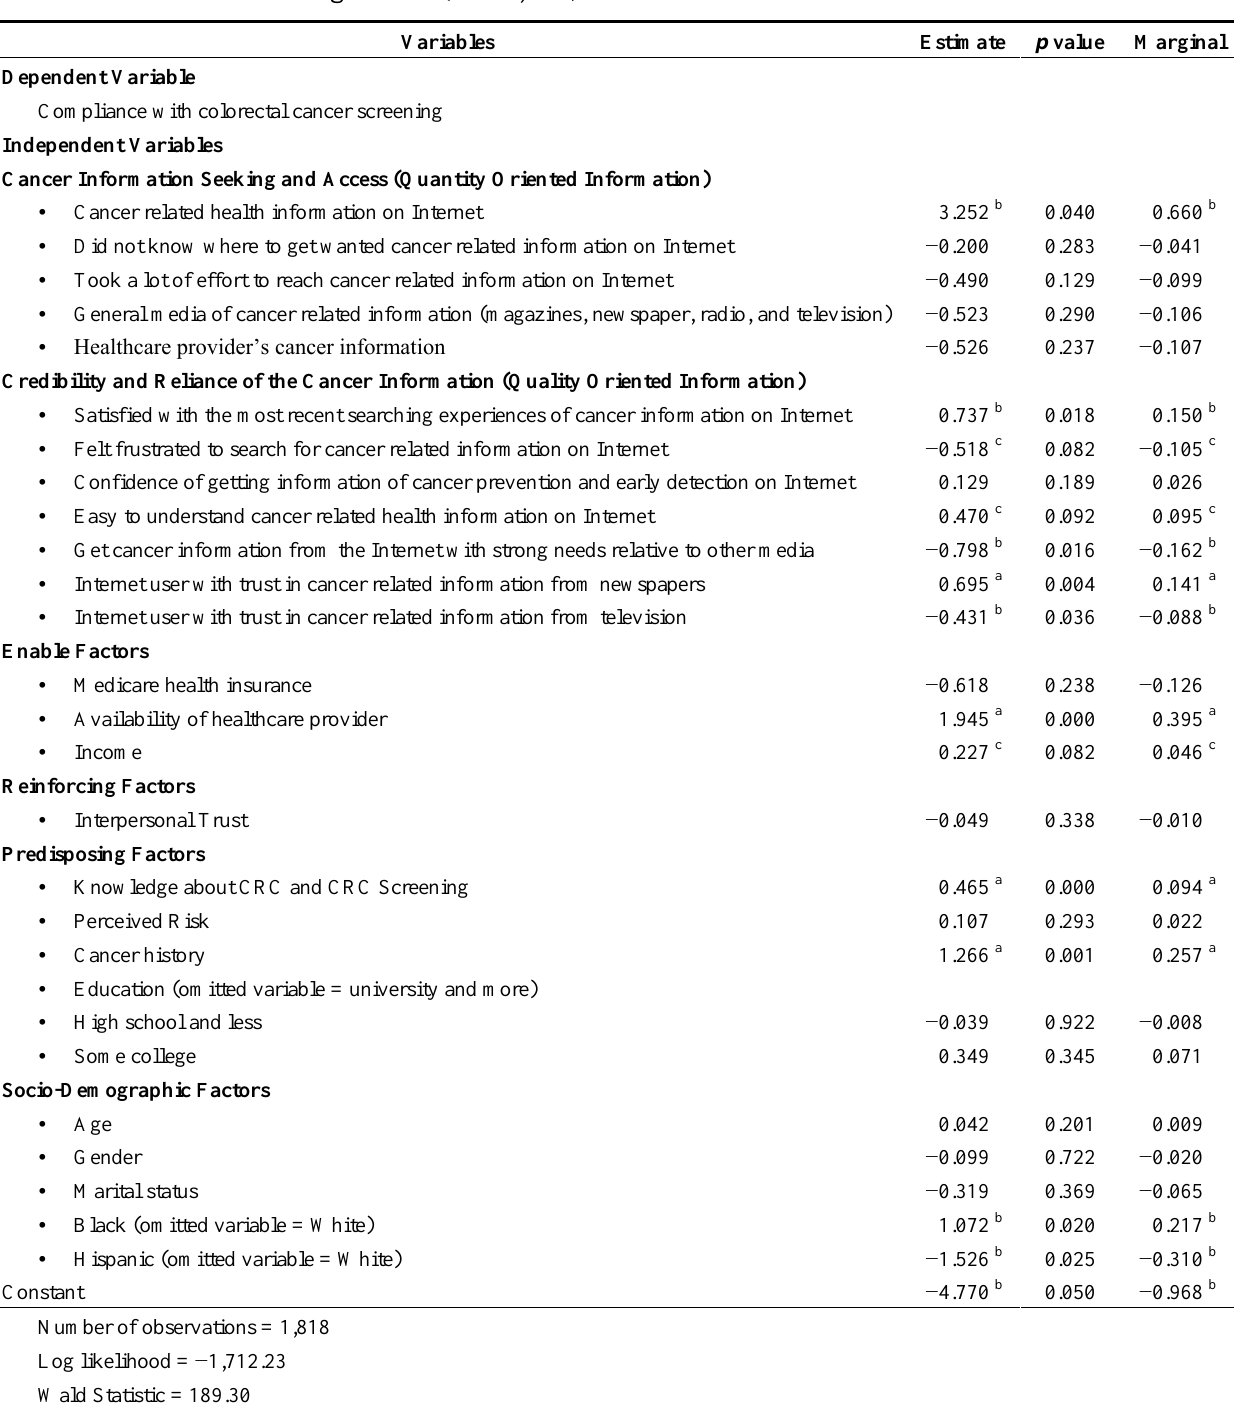
Table 2. Cancer related health information on the Internet and colorectal cancer screening: the results of Probit regression (N =